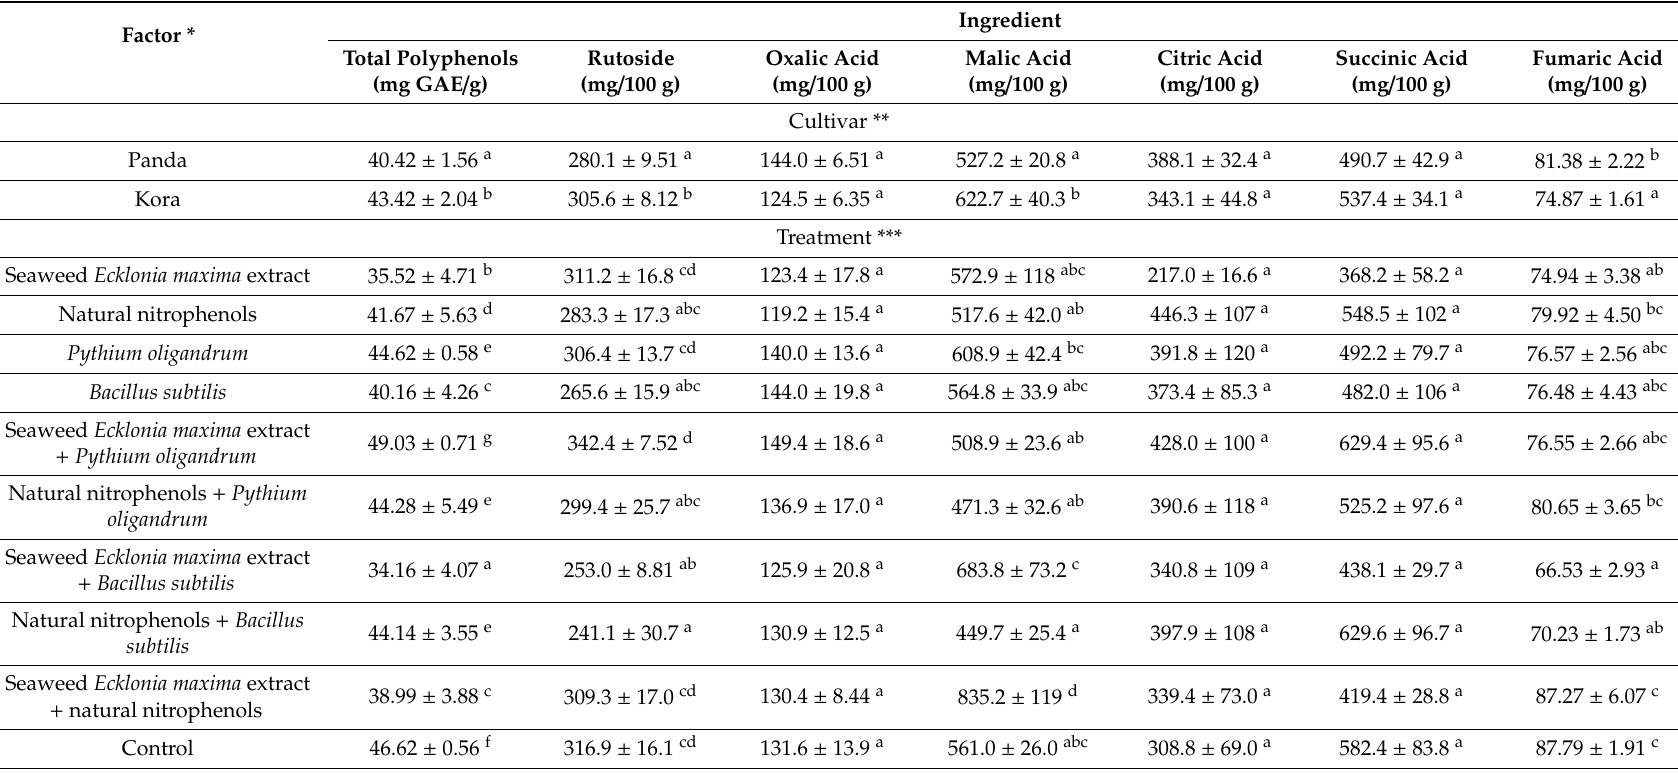
Table 2. E ff ect of cultivar and treatment on total polyphenols, rutoside, and organic acids content in buckwheat